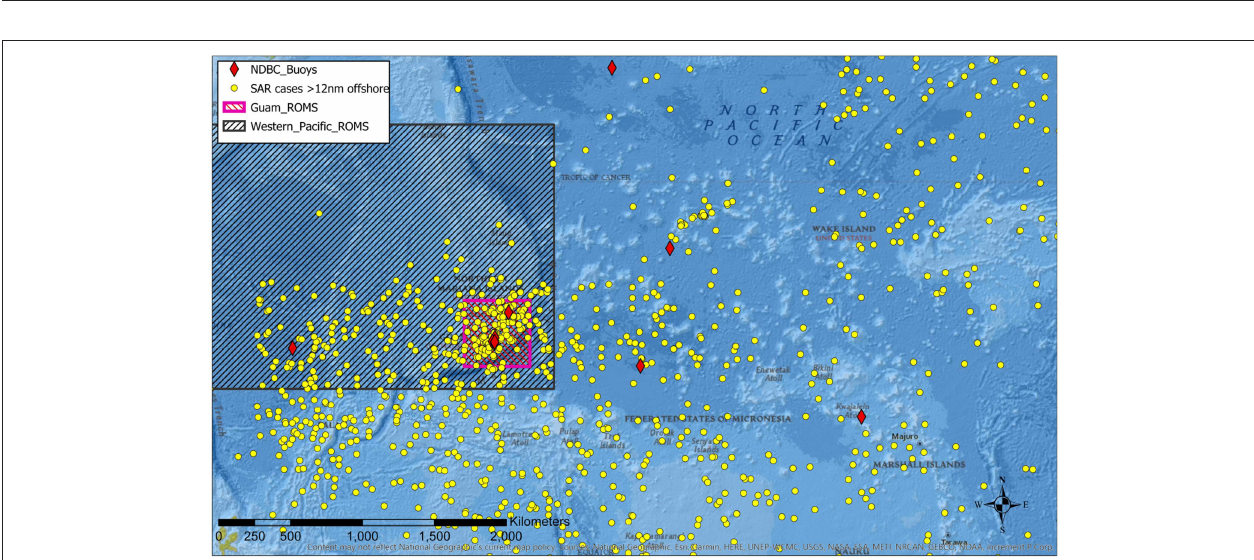
FIGURE 2 | Search and Rescue cases (yellow dots) in the Western Pacific region from 2002 through 2018. Only offshore cases ( > 12 nm from land) are shown. Red diamonds are the locations of moored surface buoys. The hatched areas represent coverage of ROMS models.